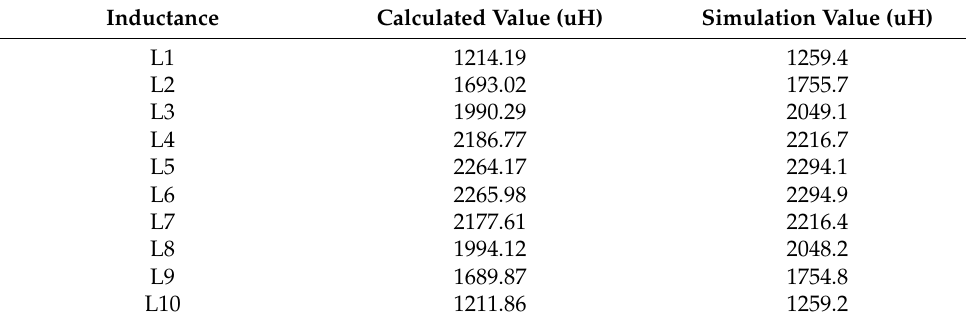
Table 2. Inductance values of windings.